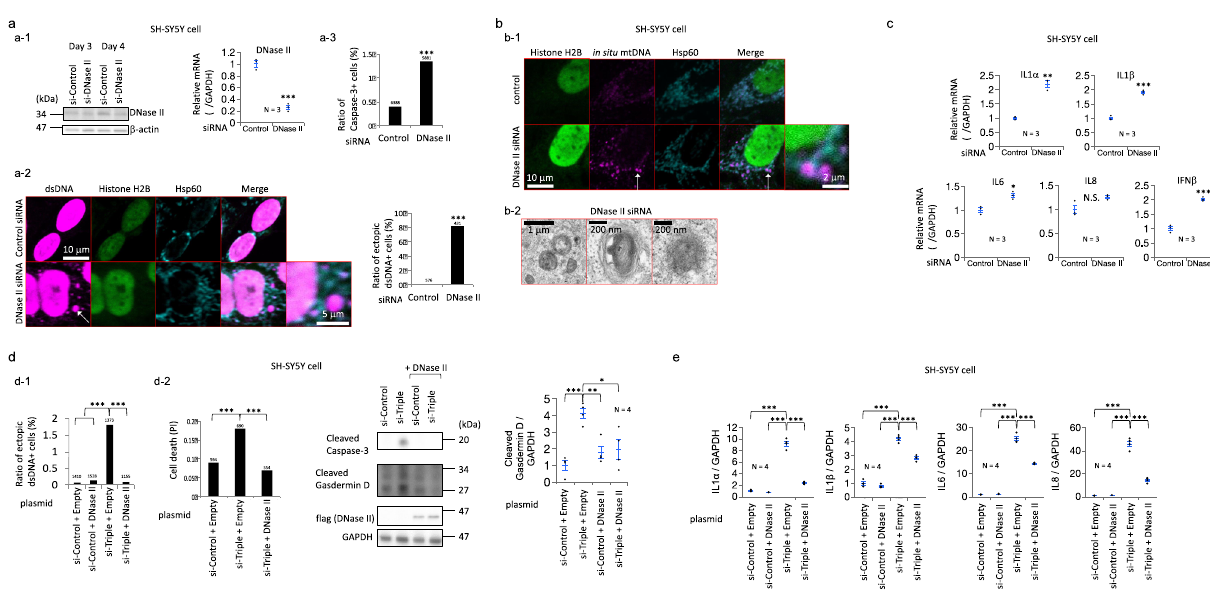
Fig. 2 Effects of DNase II on the cytosolic accumulation of mitochondrial DNA and cell death. a ( a-1 ) DNase II knockdown (6 days after transfection) in SH-SY5Y cells. siRNA-mediated knockdown was con fi rmed at the mRNA and protein (western blotting) levels. a-2 Immunostaining for dsDNA, histone H2B, and Hsp60 in SH-SY5Y cells transfected with the DNase II siRNA shows cytosolic dsDNA deposits (white arrow). The bar graph shows the ratio of ectopic dsDNA + cells among SH-SY5Y cells transfected with DNase II siRNAs. a-3 The death of DNase II-depleted cells was assayed by immuno fl uorescence staining for caspase-3. b ( b-1 ) In situ hybridization of mitochondrial DNA and coimmunostaining for histone H2B and Hsp60 in SH- SY5Y cells transfected with DNase II siRNA. A white arrow indicates cytosolic dsDNA of mitochondrial origin. b-2 Transmission electron micrographs of SH-SY5Y cells transfected with the DNase II siRNA. c qPCR analysis of DNase II, IL-1 α , IL-1 β , IL-6, IL-8, and IFN- β mRNAs in DNase II-depleted SH-SY5Y cells. N.S.: statistically not signi fi cant. d Effects of DNase II overexpression on the death of SH-SY5Y cells with GBA, ATP13A2, and PINK1 knockdown. d-1 The increase in cytosolic dsDNA deposits in GBA-, ATP13A2-, and PINK1-depleted SH-SY5Y cells were suppressed by DNase II overexpression. si- Triple: Knockdown of GBA, ATP13A2, and PINK1 expression with siRNAs. d-2 Cell death and rescue effects were assayed using western blotting for cleaved Caspase-3 and cleaved Gasdermin D and propidium iodide (PI) staining. si-Triple: Knockdown of GBA, ATP13A2, and PINK1 expression with siRNAs. e Effects of DNase II overexpression on the type I IFN responses of SH-SY5Y cells with GBA, ATP13A2, and PINK1 knockdown. si-Triple: Knockdown of GBA, ATP13A2, and PINK1 expression with siRNAs. The statistical details are described in Supplementary Table 4. Source data of Fig. 2 are provided as a Source Data fi